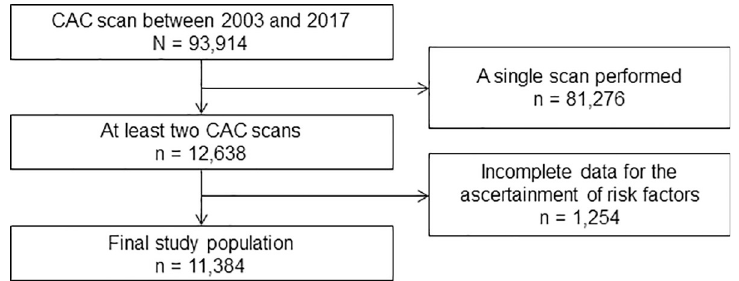
Fig 1. Flow chart of the study participant selection process. CAC, coronary artery